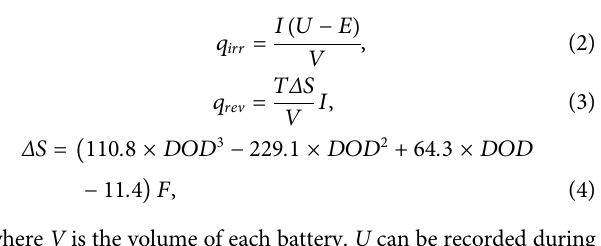
Frontiers in Energy Research |